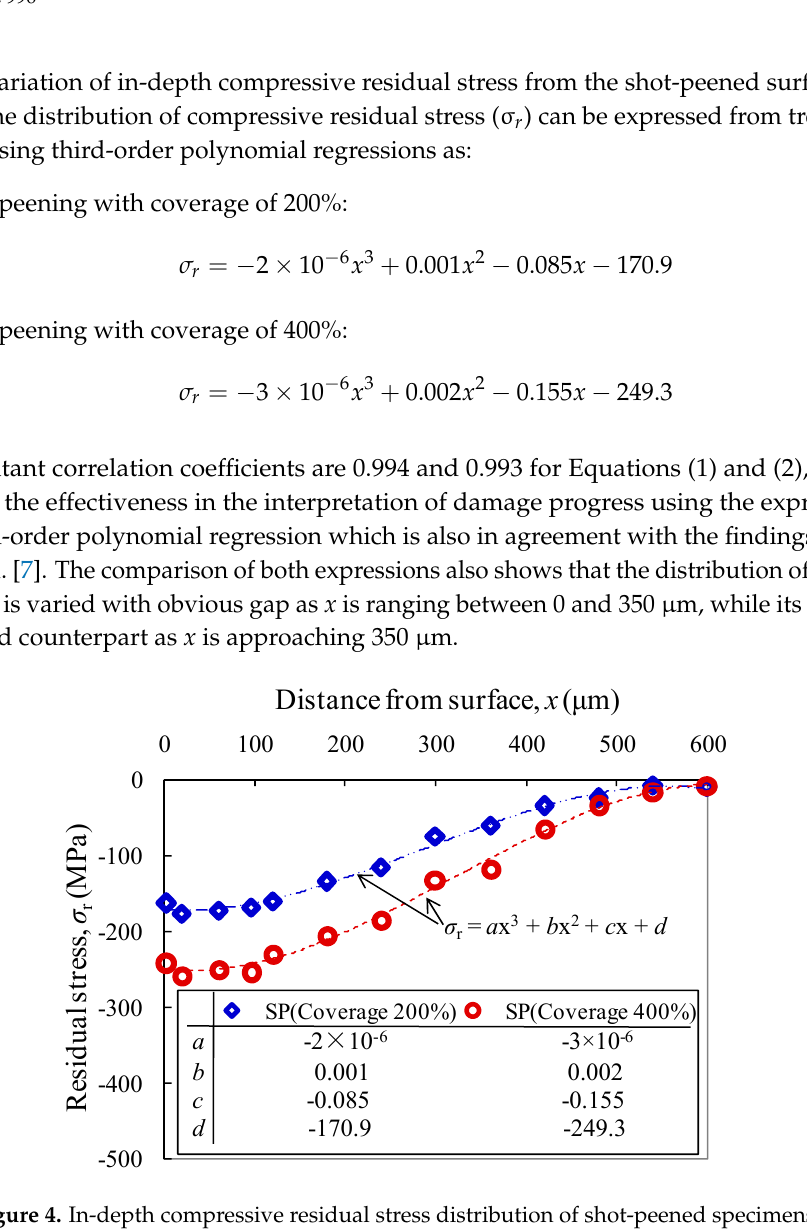
Figure 4. In-depth compressive residual stress distribution of shot-peened specimens.